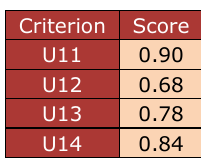
Table 3. Criteria scores of